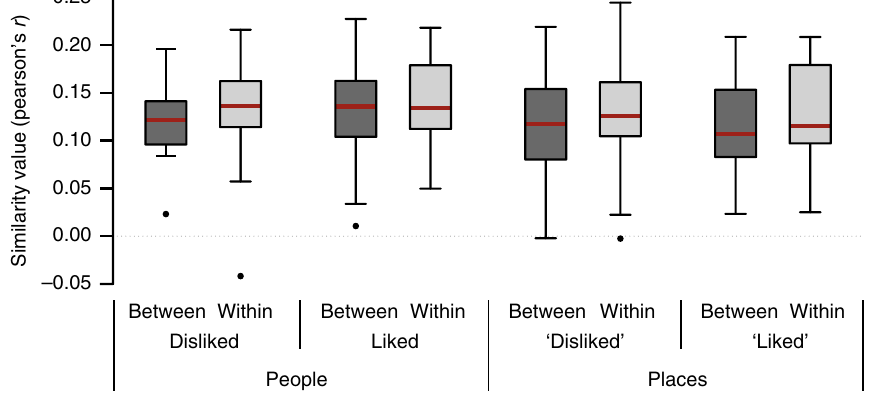
Fig. 2 Representational-similarity analysis (RSA) yields environmental representations in the vmPFC. a The vmPFC region-of-interest used for all fMRI analyses (following 60 ) b Full representational-similarity matrix indexing the similarity (expressed as Pearson correlation coef fi cients) between the activity patterns of any two simulated episodes. c To test whether the vmPFC carried information about individual people and places, we examined the replicability of the associated activity patterns across phases I and III. If the vmPFC codes for information about particular people and places, we expect greater similarity for the repetition of the same element (within-item similarity) than for the comparison of an element with a different element of the same category (e.g., other places paired with liked people) (between-item similarity). d Consistent with this prediction, we observed greater within-item than between-item similarity across the different categories. The activity pattern in the vmPFC thus carries information about individual, personally known people and places. Boxplots indicate the median, central quartiles, and + / − 2.7 SD. Dots denote outliers beyond that range. pl,